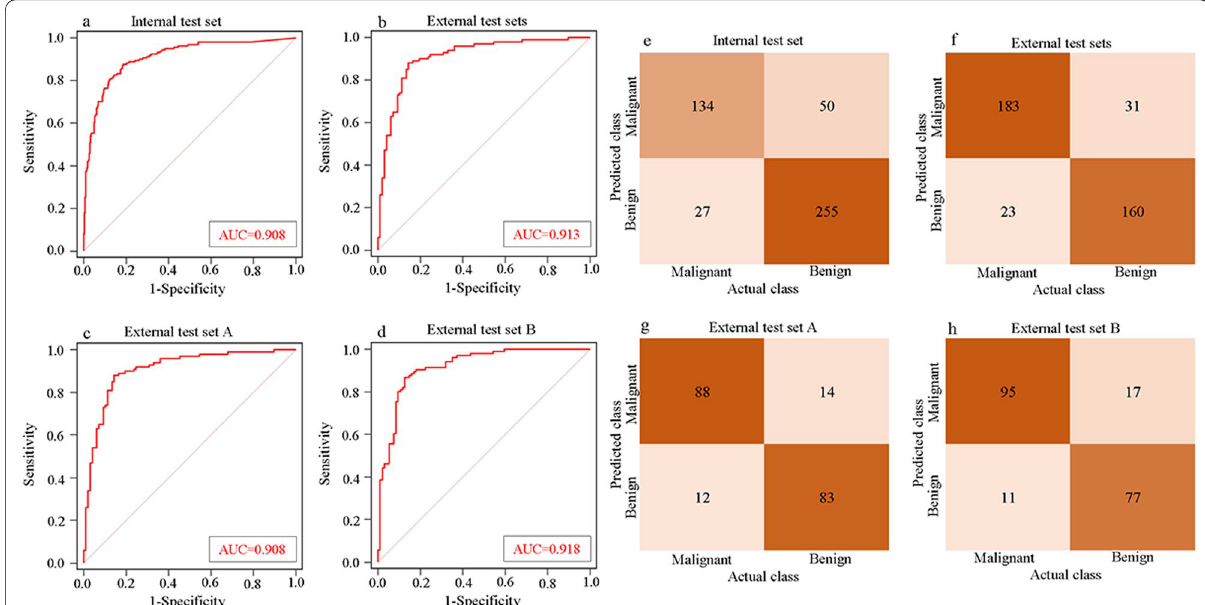
Fig. 2 Areas under the receiver operating characteristic curves (AUCs) of the model with the internal test set ( a ), the external test sets ( b ), the external test set A ( c ), and the external test set B ( d ). The confusion matrices of the model in distinguishing benign and malignant breast lesions with the internal test set ( e ), the external test sets ( f ), the external test set A ( g ), and the external test set B ( h ). Actual class, the pathology diagnosis; Predicted class, the binary prediction result of the deep learning model